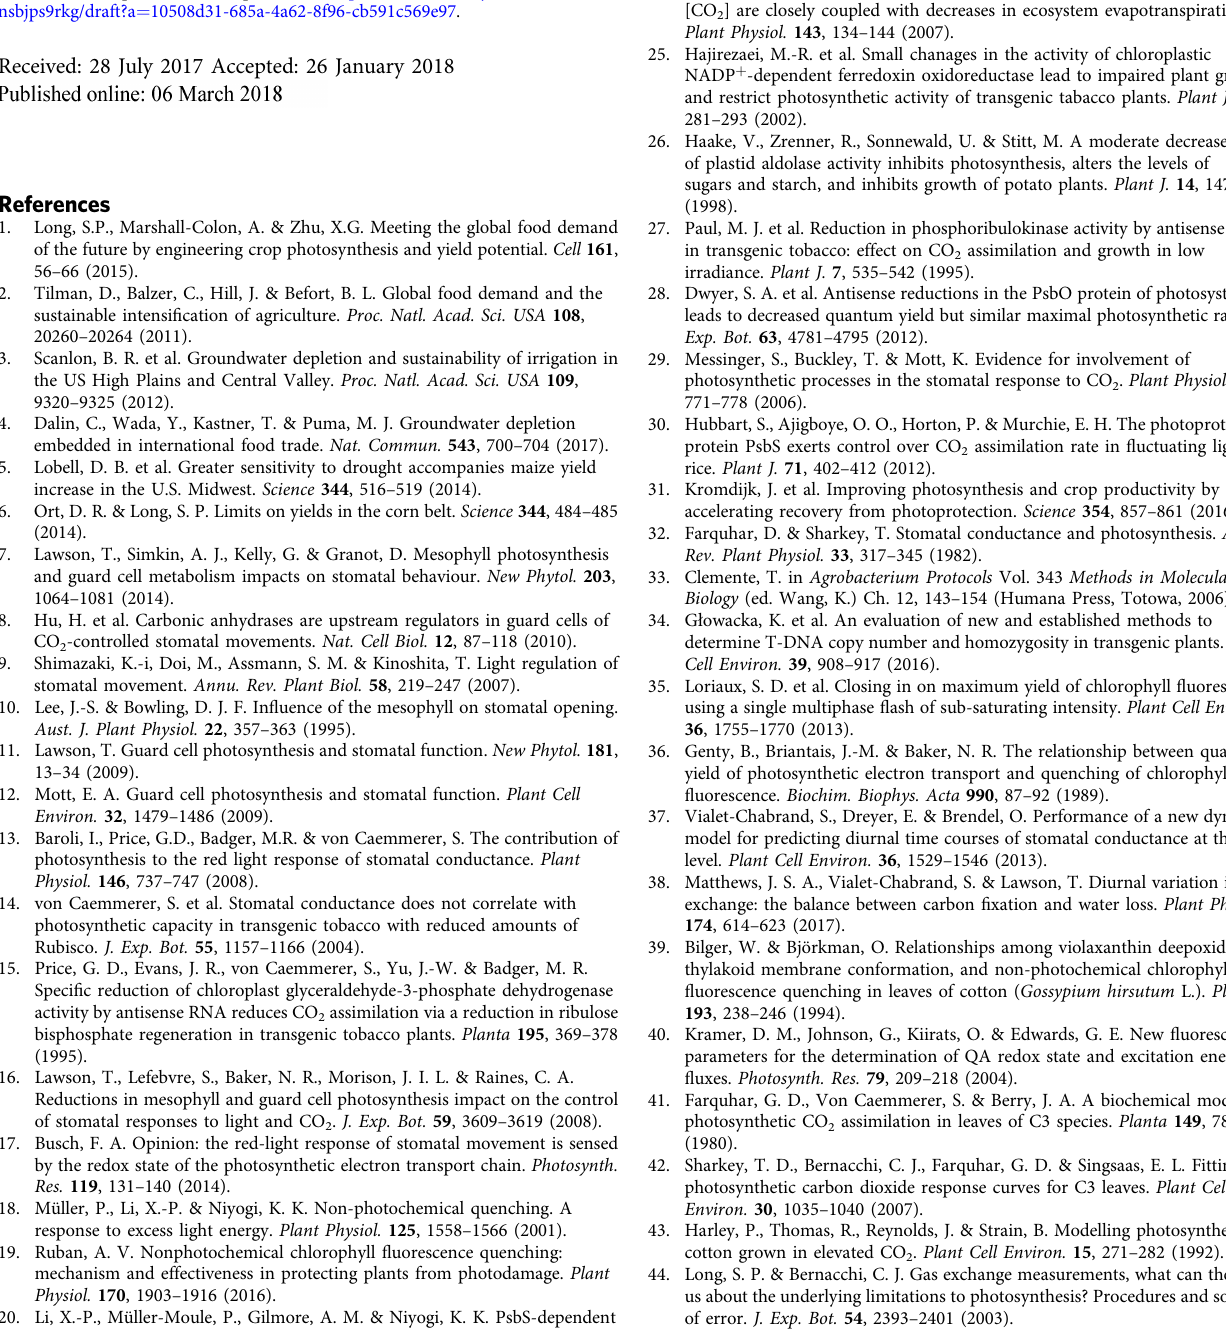
fi eld gas exchange data to account for variation caused by N – S plant position and time of day. Biomass, leaf area, and plant height data were analyzed with a linear mixed model accounting for block and genotype effects with Welch – Satterthwaite adjustment of degrees of freedom to account for the different replication rate of WT (PROC MIXED). Signi fi cant genotype effects in ANOVA ( α = 0.05) were followed by testing of genotype means against WT control ( α = 0.05), using Dunnett ’ s multiple comparison correction. Correlations between Q A redox state with g s and protein levels and with A n / g s were evaluated using Pearson ’ s correlation coef fi